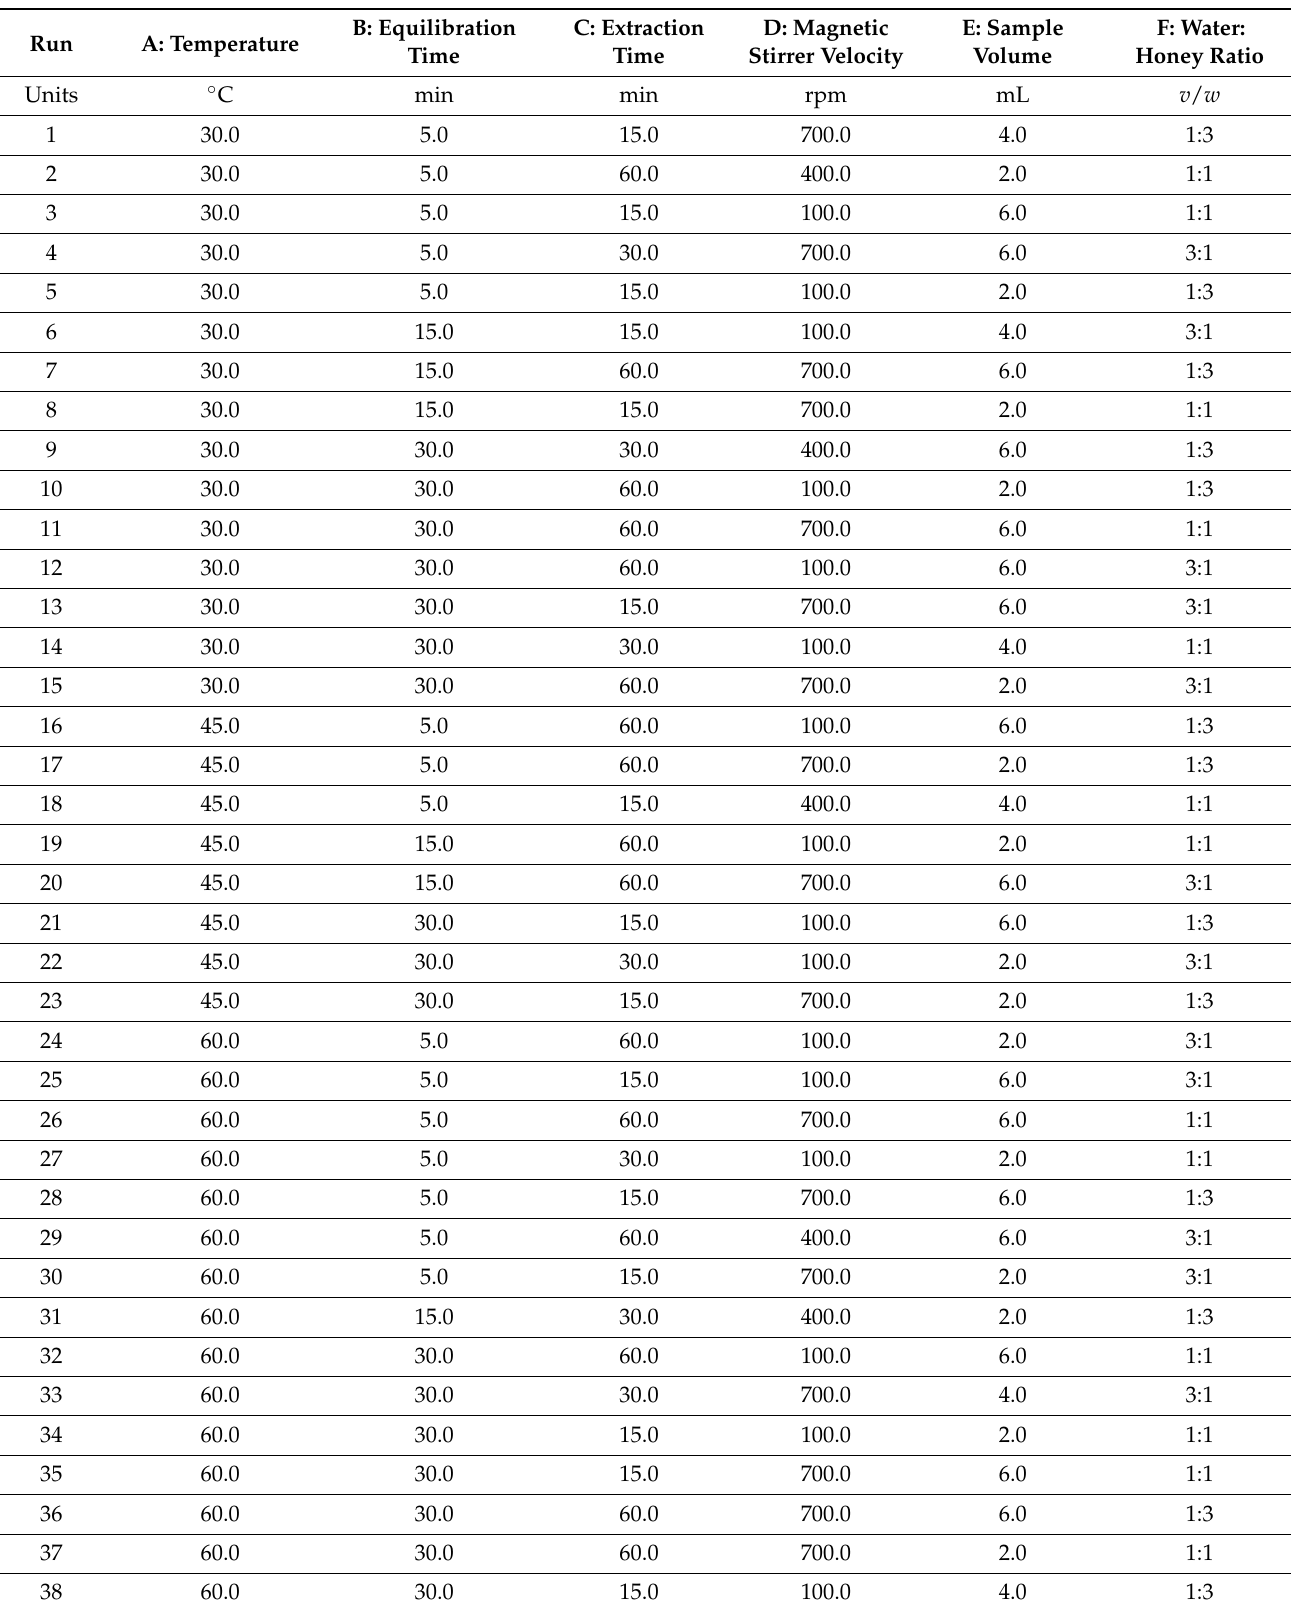
Table 1. Independent experimental factors and design layout